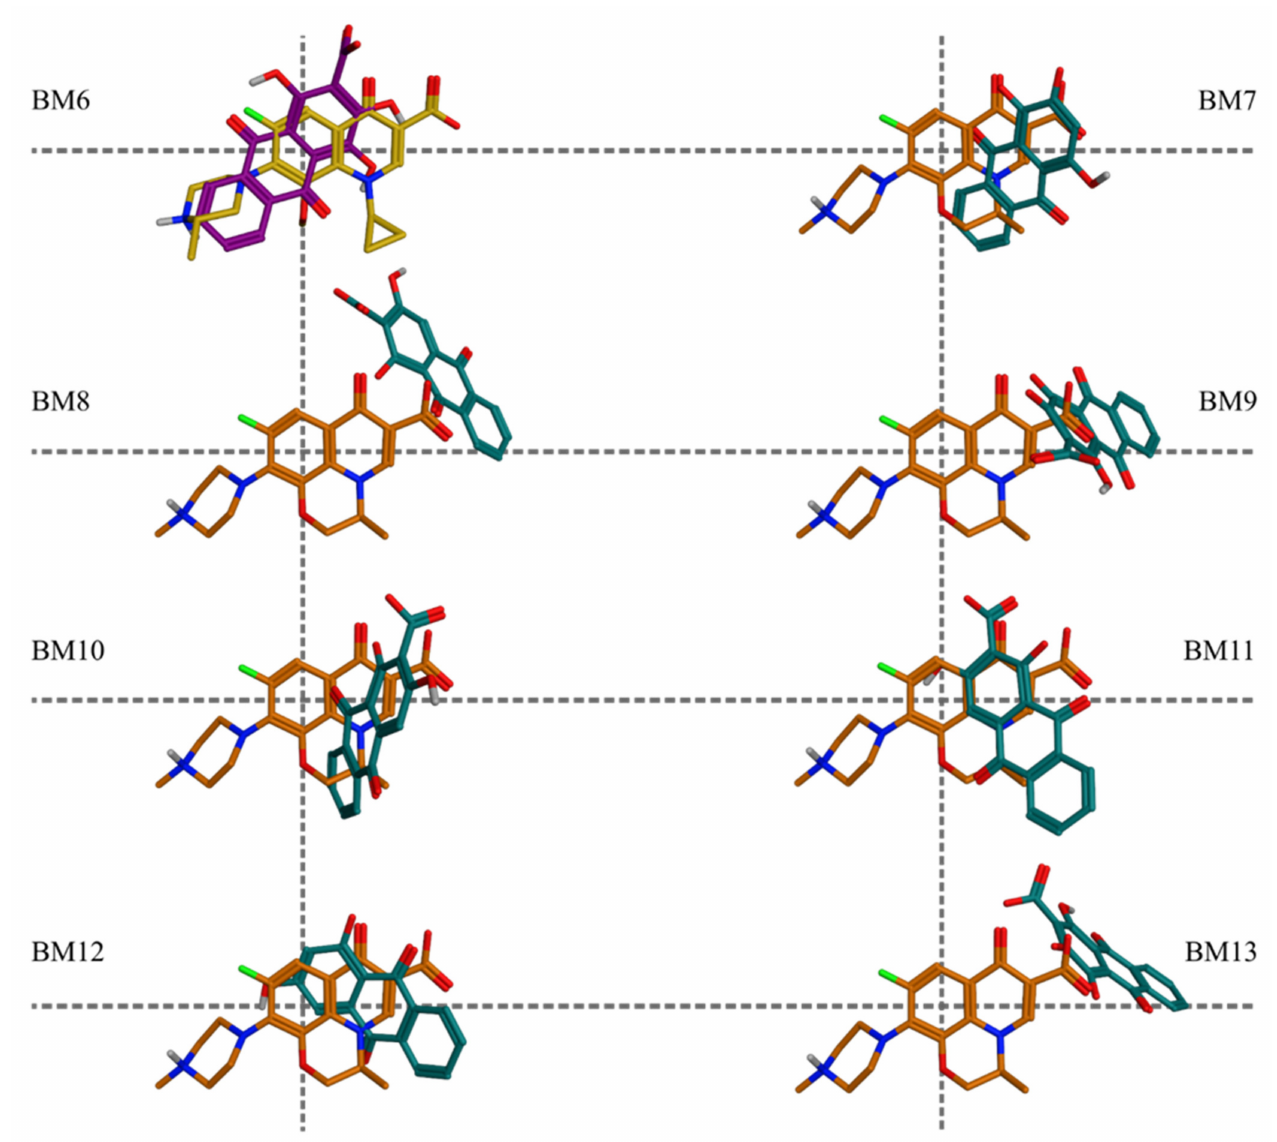
Figure 4. Unique binding modes predicted in the two enzymes. In DNA gyrase, BM6 is illustrated by pseudopurpurin (dark violet), overlaid on (S)-gatifloxacin (yellow); in DNA topoisomerase IV, the BMs are illustrated by overlay on (S)-levofloxacin (orange) of the following hydroxyanthraquinones (teal): purpurin (BM7), munjistin (BM8, BM10, and BM11), pseudopurpurin (BM9 and BM13), and xanthopurpurin